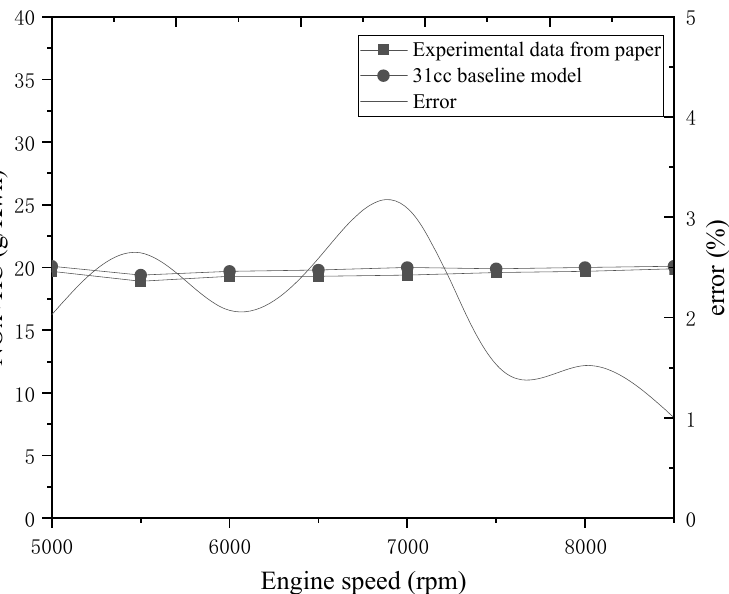
Figure 6. HC + NOx emissions comparison from experimental results as obtained from the Ricardo WAVE simulation.